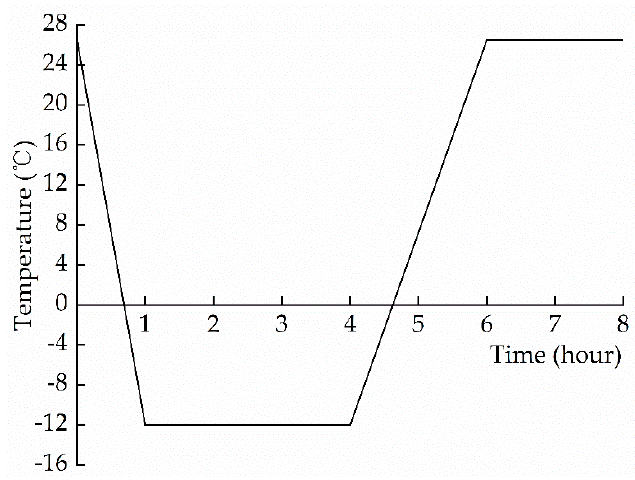
Figure 2. Temperature change during one freeze–thaw cycle.